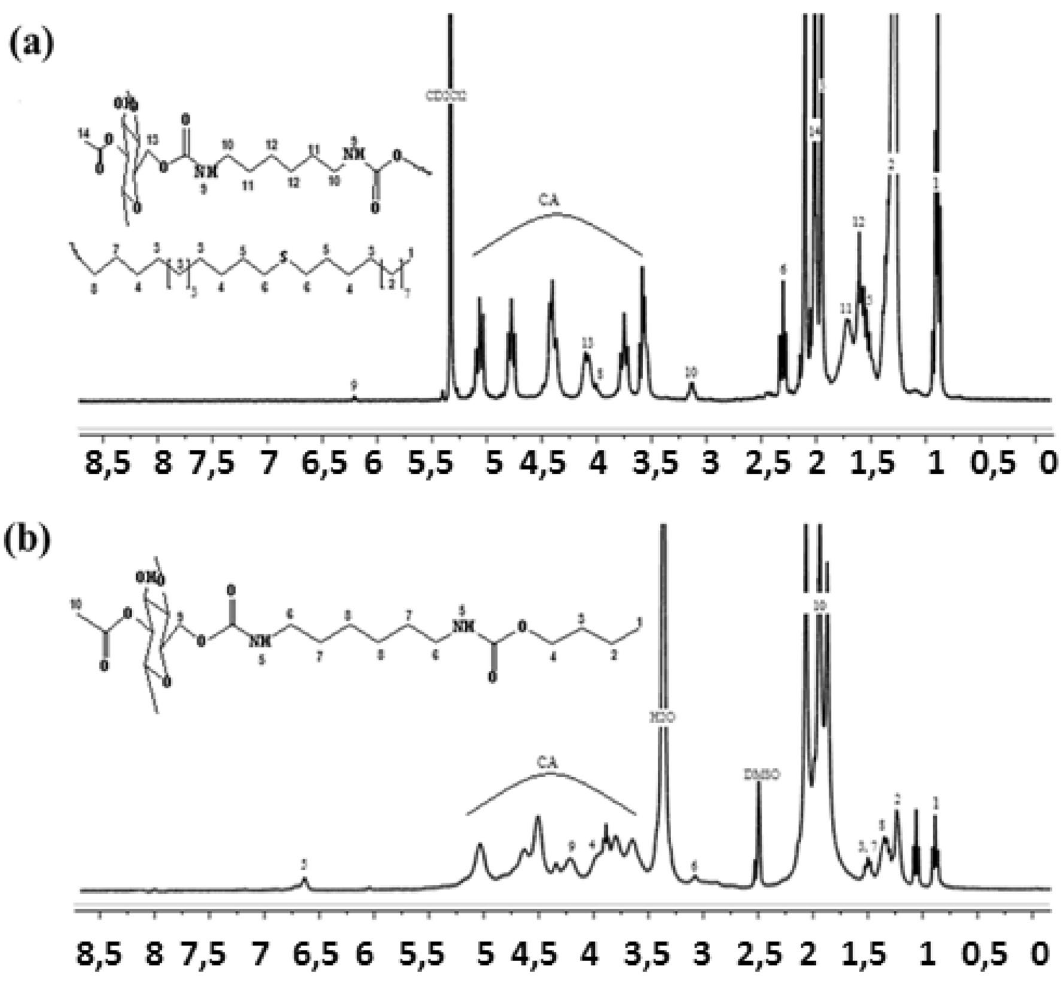
Figure 4. Proton NMR spectra for ( a ) CA-P 1 and ( b ) CA-P 2